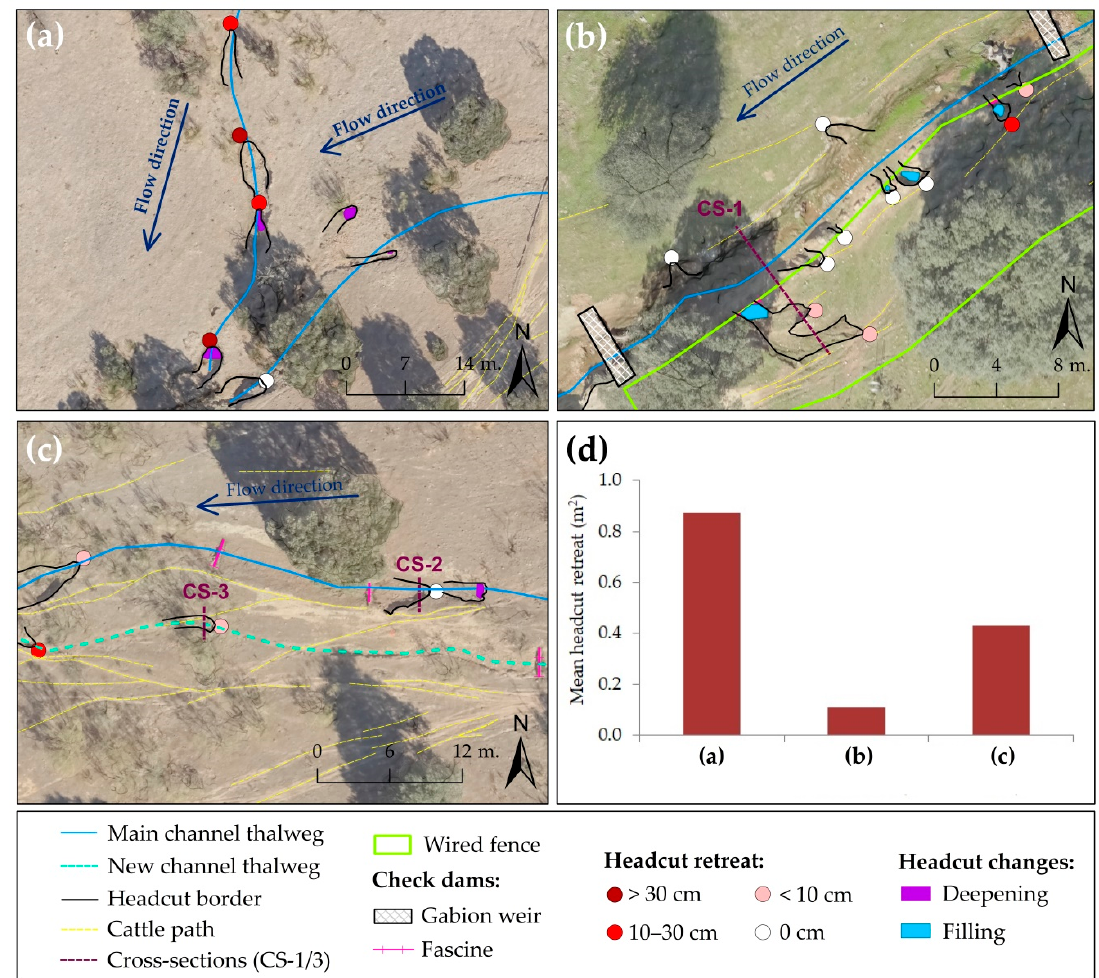
Figure 11. Headcut retreat at different locations: ( a ) the junction between the tributary and the upper reach forming the main channel; ( b ) a part of the upper reach with bank headcuts that were fenced to protect against livestock; ( c ) a part of the upper reach with unfenced headcuts at the left bank of the upper reach; and ( d ) mean headcut retreat (expressed in m 2 ) of the reaches shown in this figure during the period with restoration measures (February 2017–January 2019).